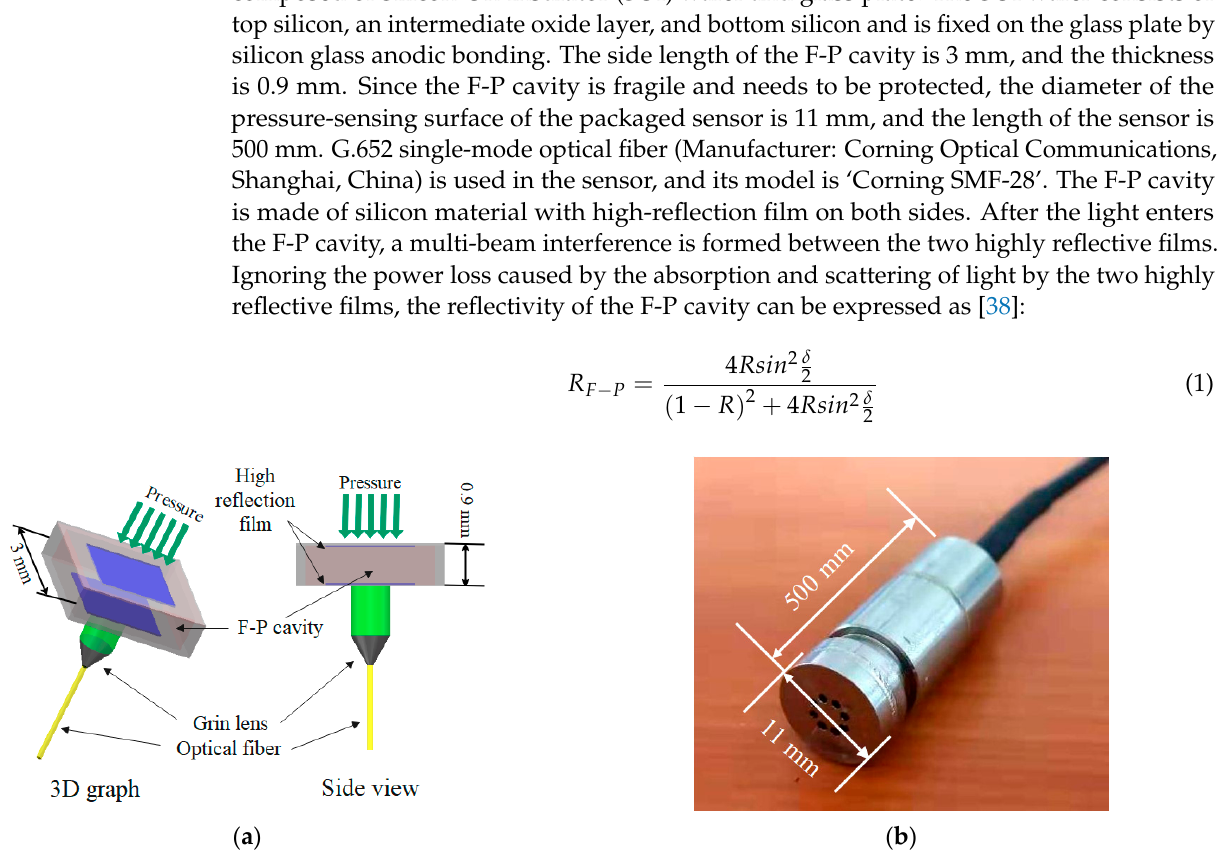
Figure 1. ( a ) Structure diagram and ( b ) image of the MEMS pressure sensor.